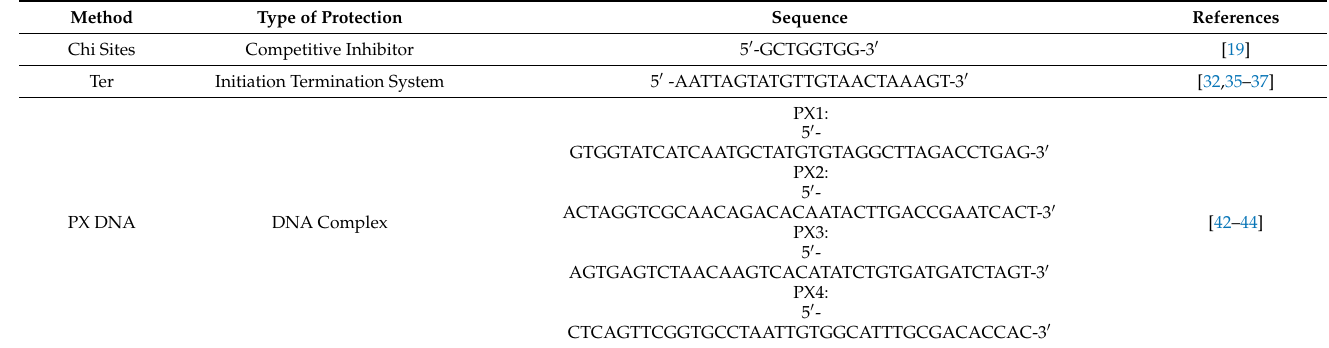
Table 3. Specified sequences for DNA based protection mechanisms: Chi Sites, PX DNA, and Tus-Ter